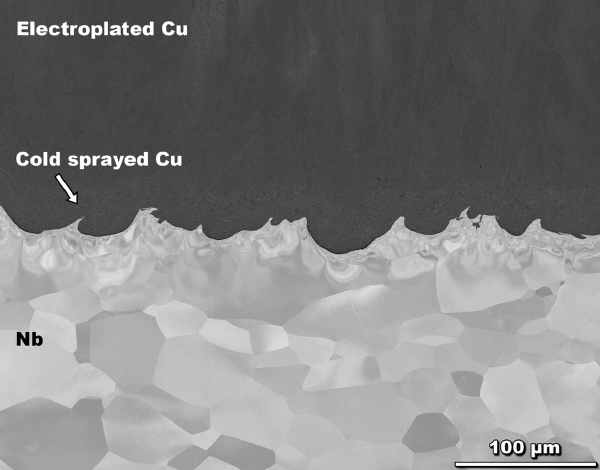
FIG. 12. SEM image of the cross section of a Nb/Cu sample with the interface Cu layer between Nb and electroplated Cu being deposited by cold